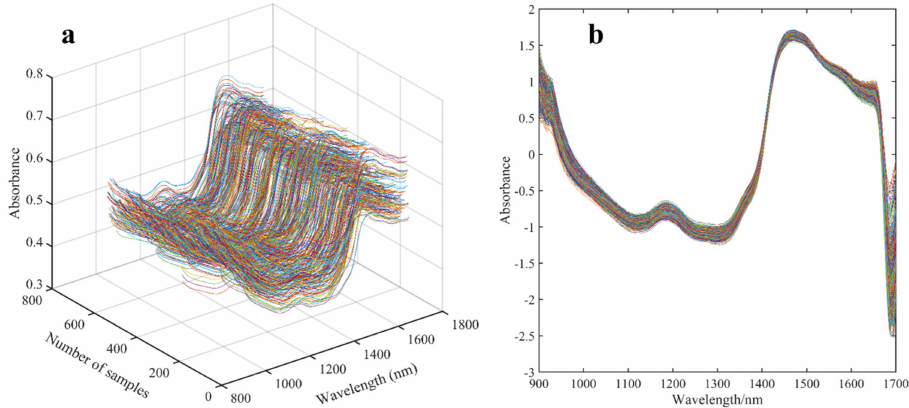
Figure 2. Raw and SNV pre − treatment spectra of samples. ( a ) Raw spectra; ( b ) SNV pre − processing